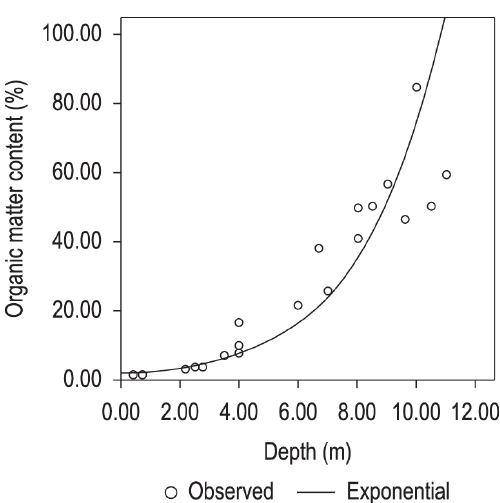
Figure 3. Relationship between organic matter (%) and depth (m) in Lake Figueira (y=1.798e 0.371x